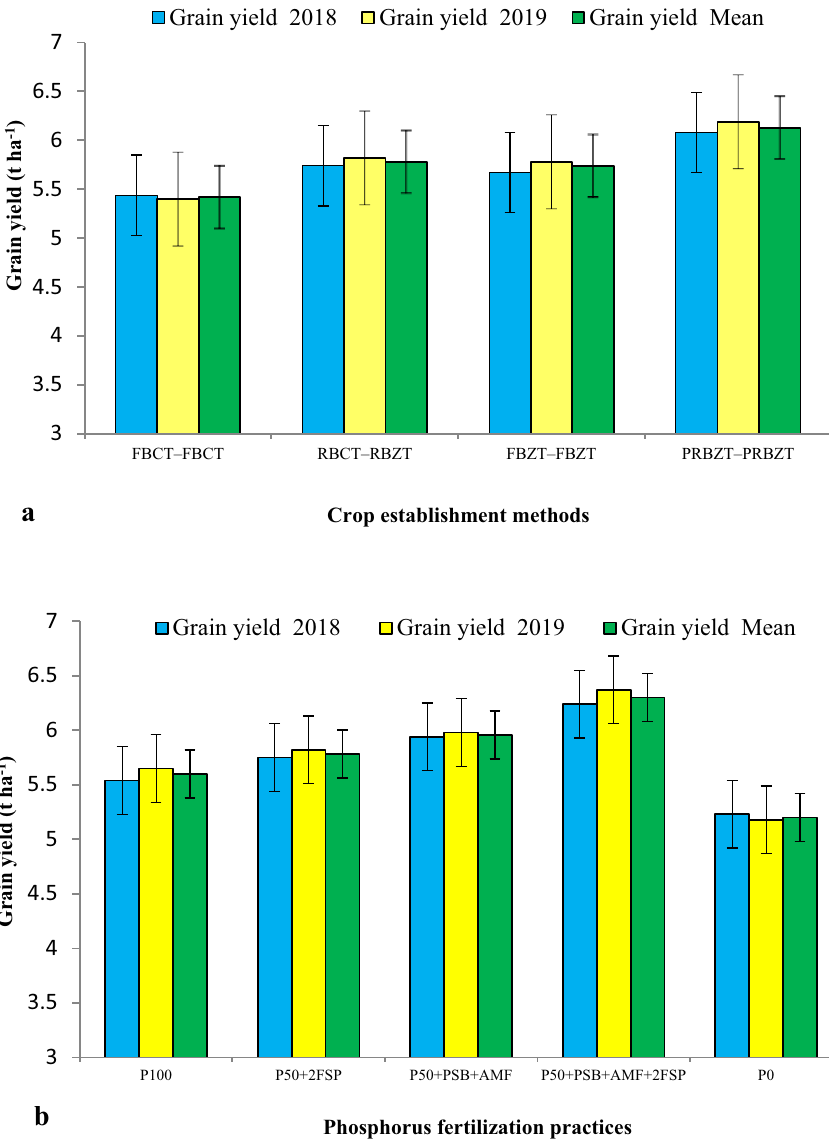
Figure 1. Influence of ( a ) CETM and ( b ) P-fertilization practices on grain yield (t ha −1 ) of maize under MWCS. The vertical bars represent LSD 0.05